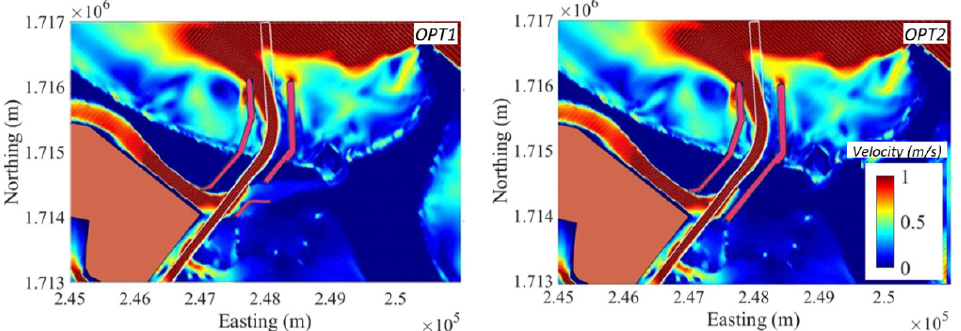
Figure 21. Current field during typhoon Molave after jetty construction.